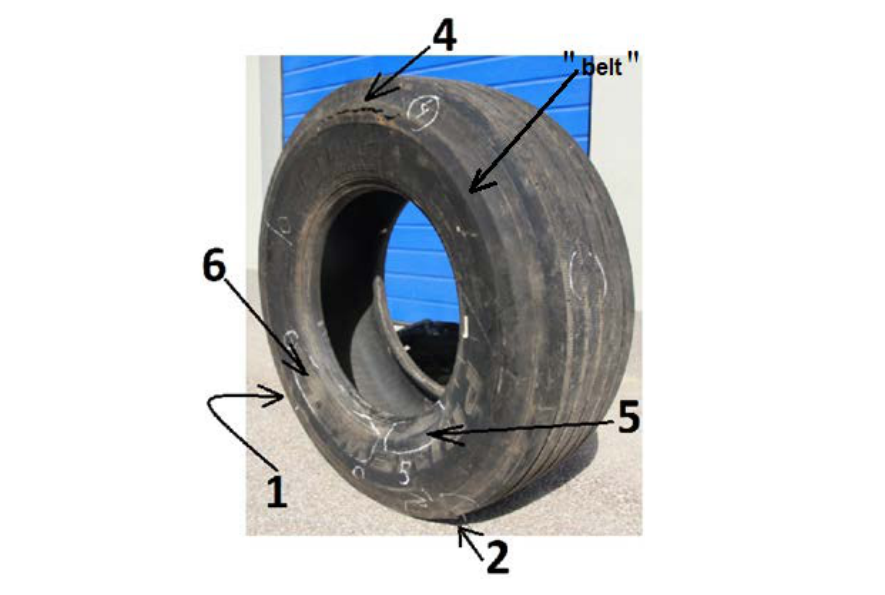
6 of 16 Figure 4. Tire markings applied during the tests: ( a ) inner side of the tire; ( b ) outer side. •